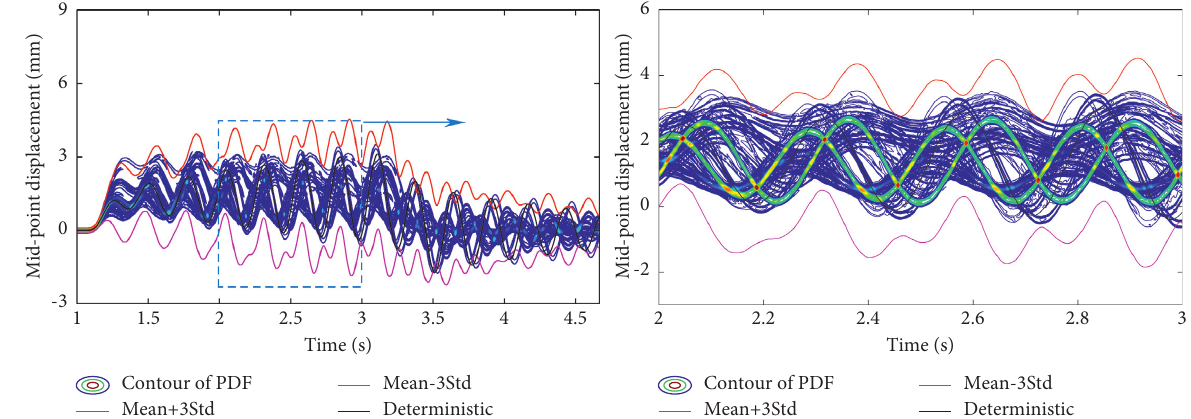
Figure 9: Contour of PDF of bridge midpoint displacement for ( v ) � 340km/h.